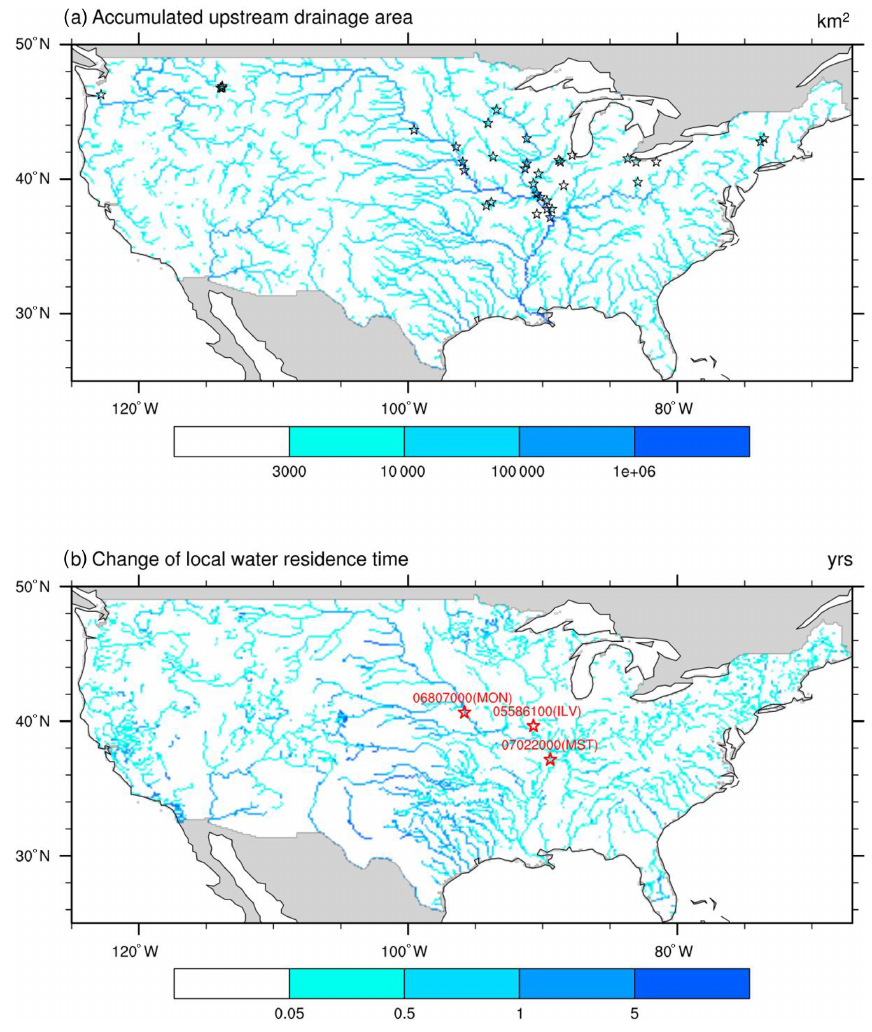
Figure 3. (a) River network displayed using upstream drainage area and 35 selected USGS stations (black stars) along the river networks (approximated). (b) Change in channel water residence time due to upstream reservoirs and three representative stations (red